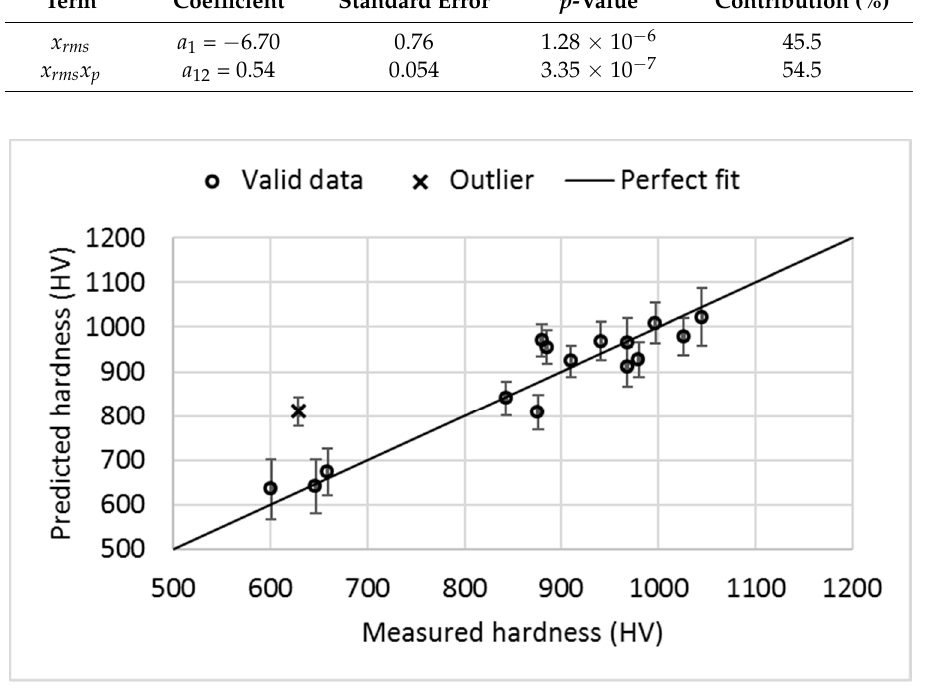
Figure 5. Predicted vs. measured hardness with the non-ground sample data set.